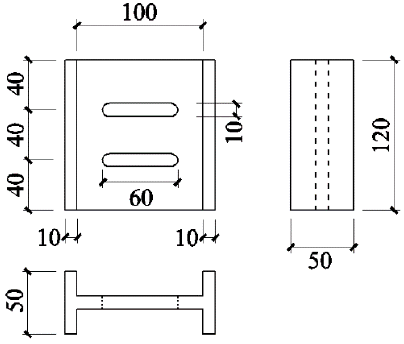
Figure 2. Details of the hysteretic dampers.